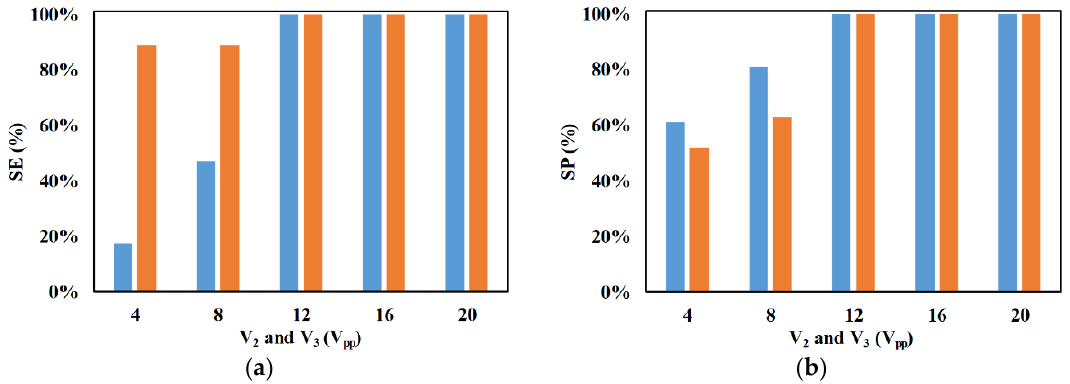
Figure 6. Variation of separation efficiency (SE) and separation purity (SP) with applied electrical potentials ( V 2 and V 3 ) for ( a ) ■ 2 μm and ( b ) ■ 2.25 μm ( d f = 60 μm, l f = 120 μm, d s = 60 μm, l s = 120 μm, w f = 6 μm, w s = 6 μm, n f = 200, n s = 200, Q m = 200 μl/h, V 1 = 4 V pp , V 4 = 4 V pp , H ch = 50 μm, W ch = 50 μm, 0 < W o ,2.25 < 30 µ m, 30 µ m < W o ,2 < 50 µ m N 1 = N 2 = 10 MHz, N 3 = N 4 = N cr ,2 = 473 kHz).